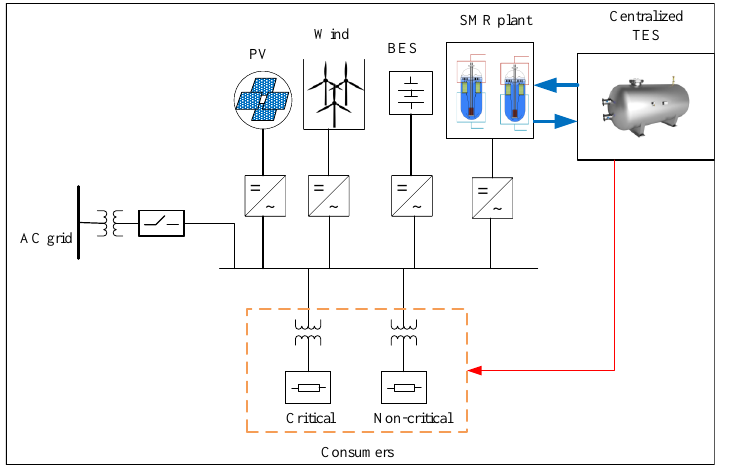
Figure 1. SMR-DER microgrid supplying heat and